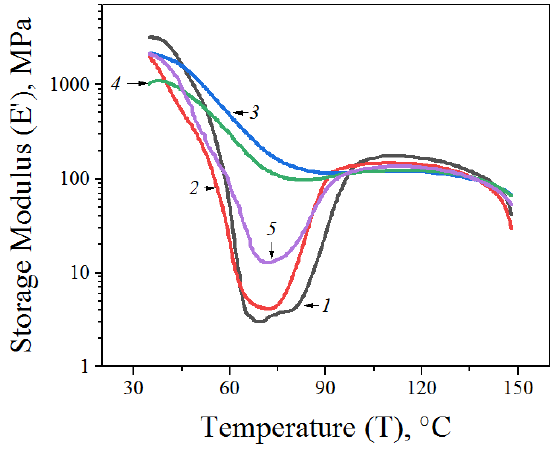
Figure 5. Storage moduli of PLA films (1) and PLA/AONF composite films with different AONF content: 2—0.1%, 3—0.2%, 4—0.5%, 5—1%.